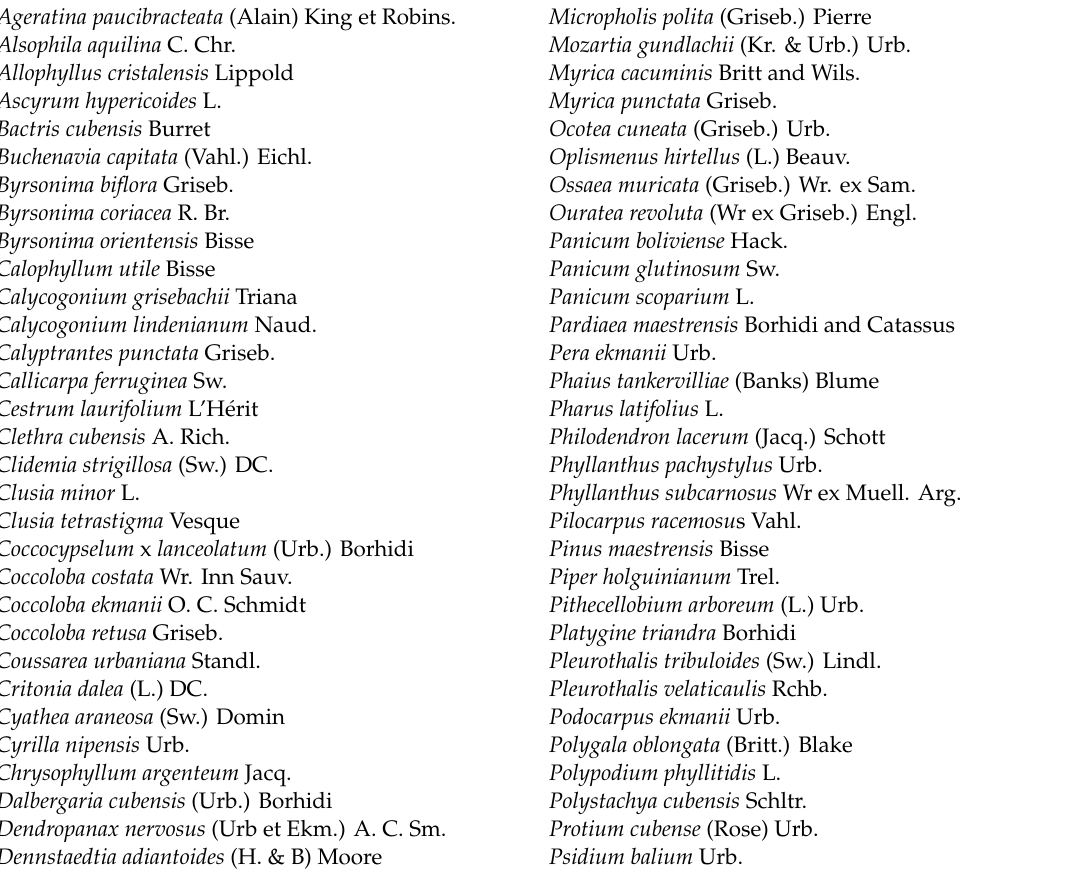
Figure 1. Jaccard distance cluster. Cluster analysis for the associations of Cuba and the Dominican Republic (DR). The six communities described in Cuba by [31–37] are separated into the community C1 and group G1 (C2, C3, C4, C5, C6). G2 includes 32 of our own relev é s and those one of [9,10] from the Table 1. Plant species found in Cuba [31,32] but not present in the relev é s from the Dominican Republic. Ageratina paucibracteata (Alain) King et